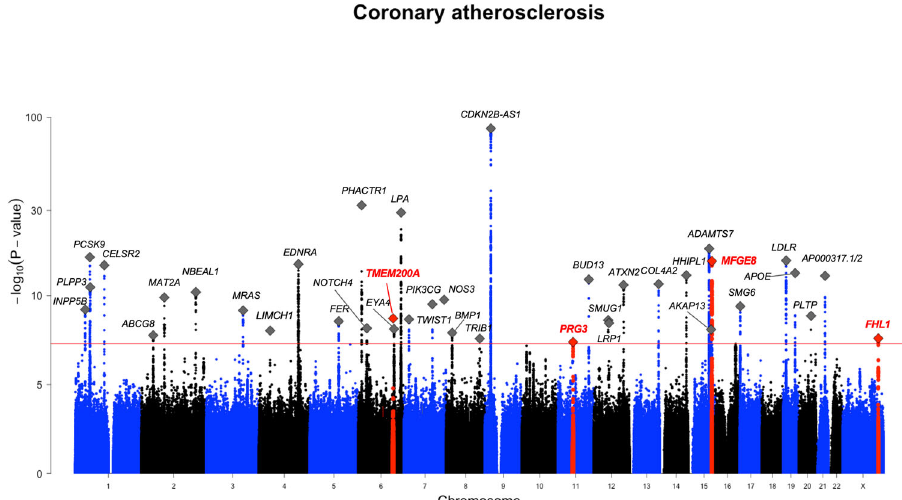
Fig. 1 GWAS results for coronary atherosclerosis in FinnGen. Total number of independent genome-wide signi fi cant associations (GWS; p < 5 × 10 -8 ) is 38, the lead variant in each marked with diamonds. Four previously unreported associations for CVD-related phenotypes are highlighted with ±750 Mb around the lead variant in the region as red and the lead variant marked with red